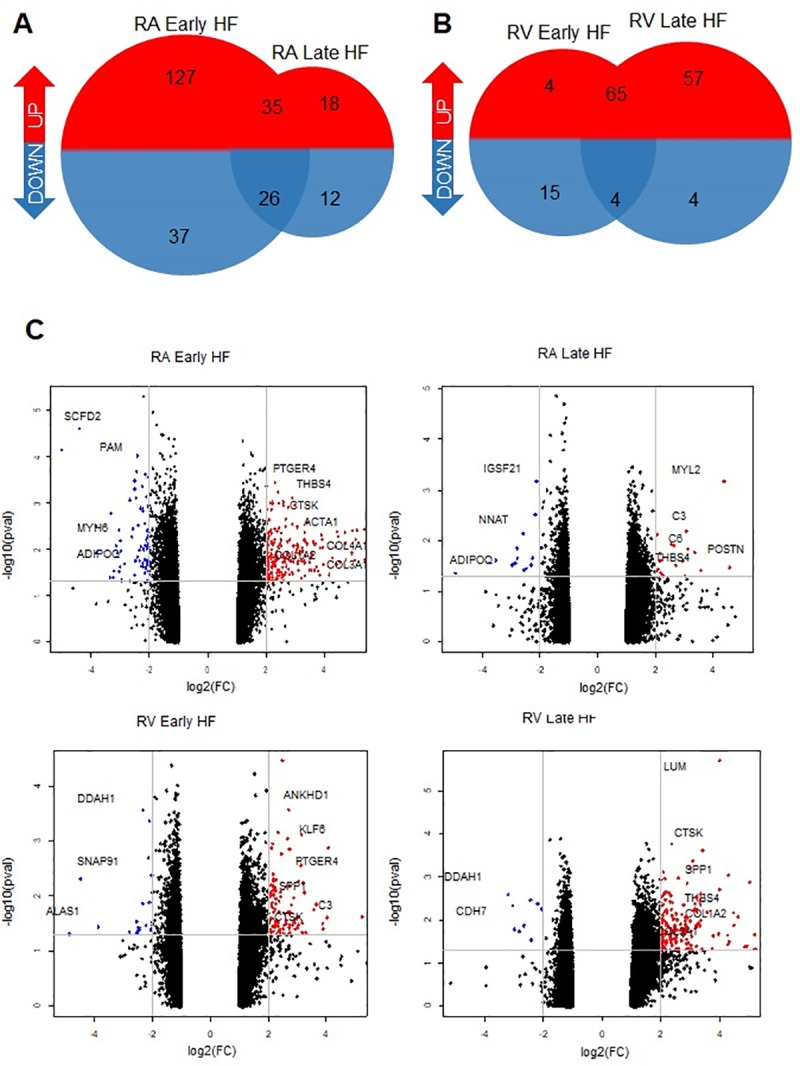
Comparison of differentially expressed genes (DEGs) between early and late stages of heart failure (HF).The Venn diagrams show the number of DEGs in each comparison and the number of upregulated (red) and downregulated (blue) overlapping genes between the early and late stages of HF in a canine model for (A) RA and (B) RV. All samples are compared to their respective control. (C) The Volcano plots show the total gene expression with positive (red) and negative (blue) log2 fold difference ≥2 (x-axis) against adjusted P-value ≤0.05 (y-axis). All other genes with adjusted P-value >0.05 are indicated in black.